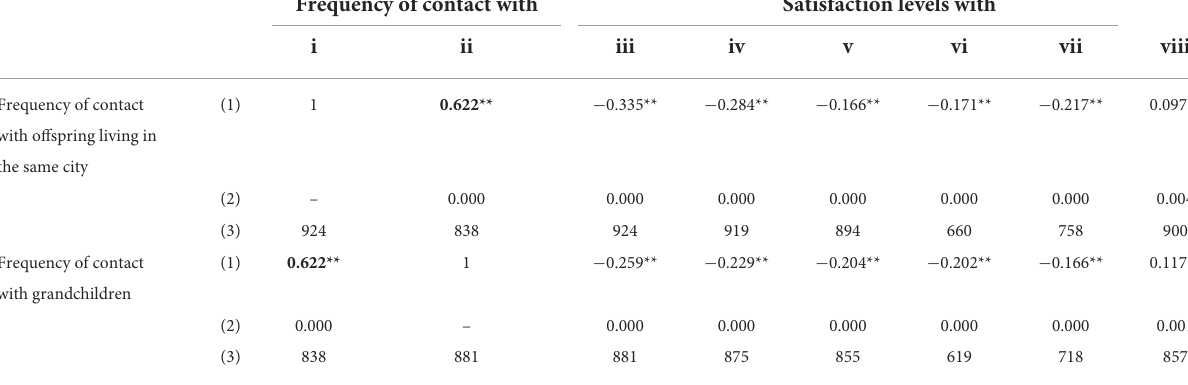
TABLE 5 Correlations between frequency of socio-family contact and satisfaction levels. Frequency of contact